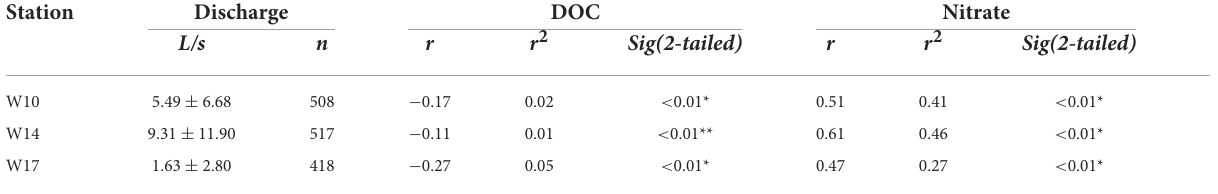
TABLE 3 Mean discharge and the linear relationship between discharge and DOC or nitrate for each sampling